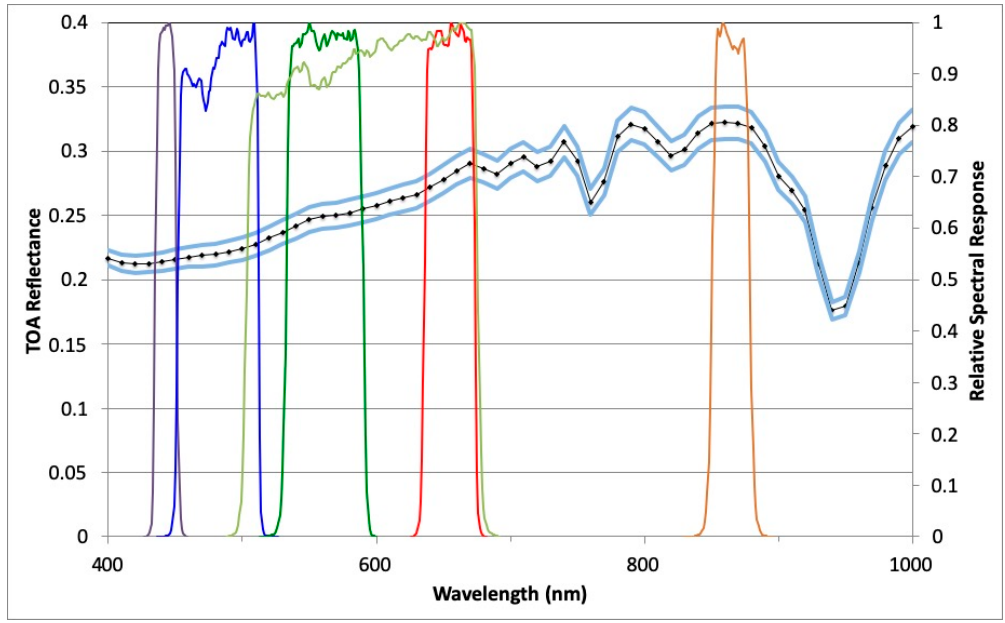
Figure 4. Sample spectral output from a single RadCalNet TOA reflectance spectrum (with associated RadCalNet uncertainty range in blue), shown with sample-relative spectral response from a current on-orbit imager.